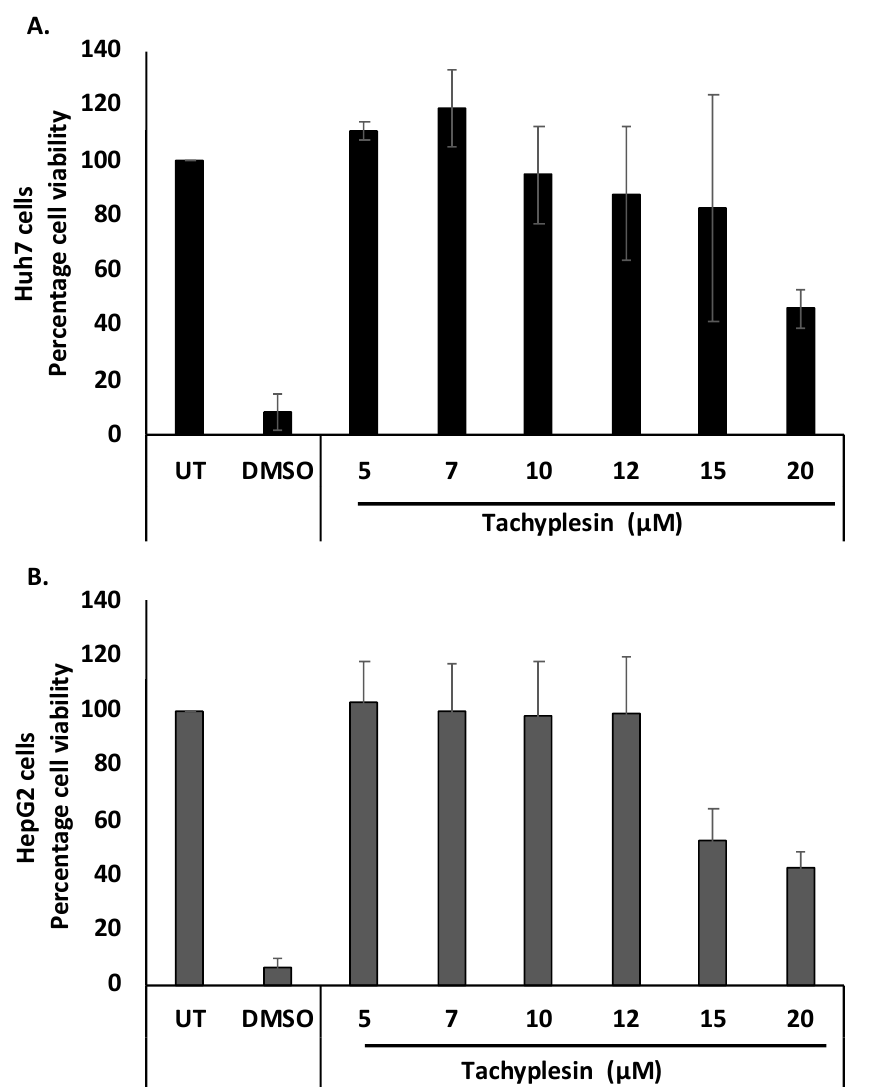
Figure 2. Cytotoxicity studies with Tpl treatment. Cell viability in ( A ) Huh7 cells and ( B ) HepG2 cells after 48 h.